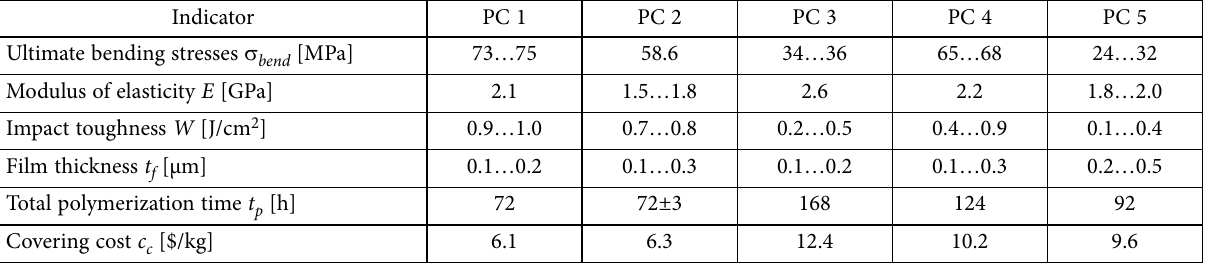
Table 5. Comparison of properties of the developed and known Protective Coatings (PC) Indicator